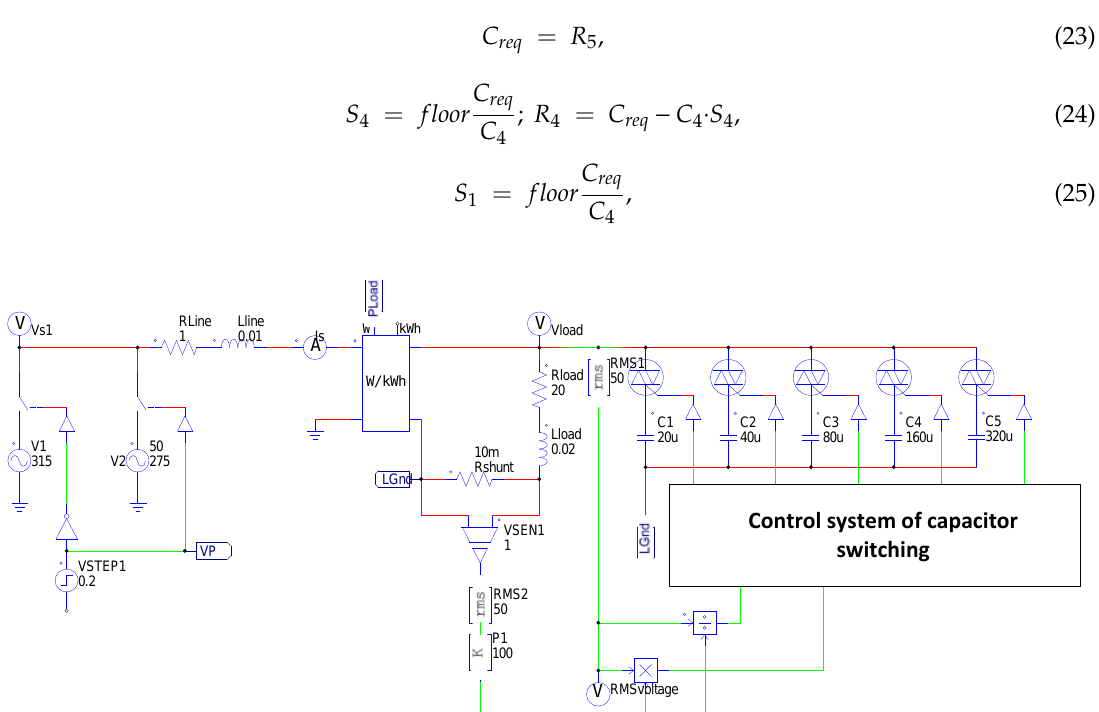
Figure 7. Dynamic behavior of output voltage and current.